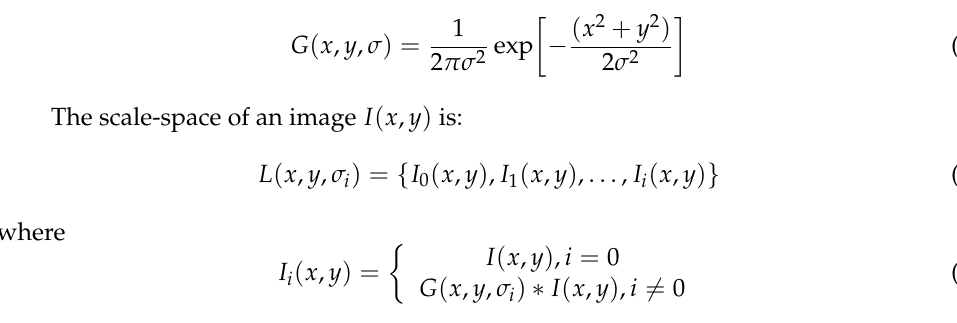
( i ) Figure 3. Examples of scale space and contour features of a image in the TID2013 database. (a) (i) Figure 4. Examples of scale space and contour features of a image in the LIVE database. In the first stage of training, the contour prediction network learns to predict contour features, and the loss function is defined by the mean square error between the predicted value and the ground ‐ truth: